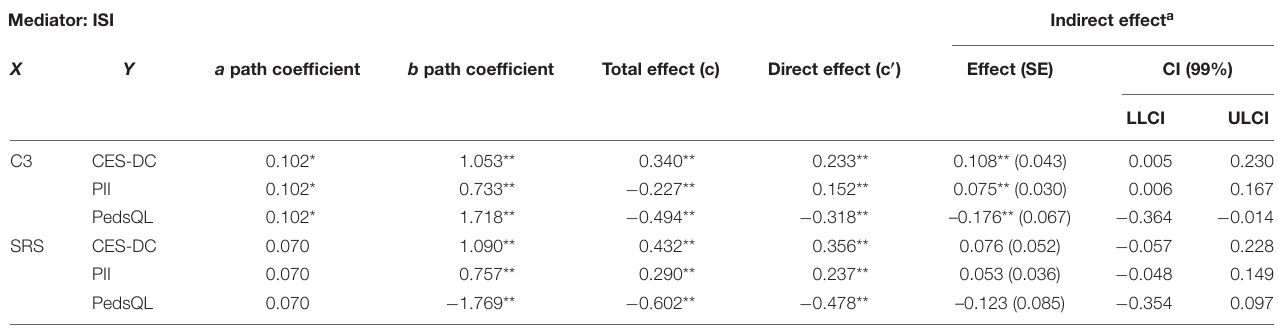
TABLE 4 | Total, direct and indirect effects of autistic traits (SRS) and ADHD symptoms (C3) on depression (CES-DC), pain interference (PII), and HRQoL (PedsQL), using insomnia (ISI) as mediator with adjustment for age, gender, and level of pain intensity (LPQ) ( n =